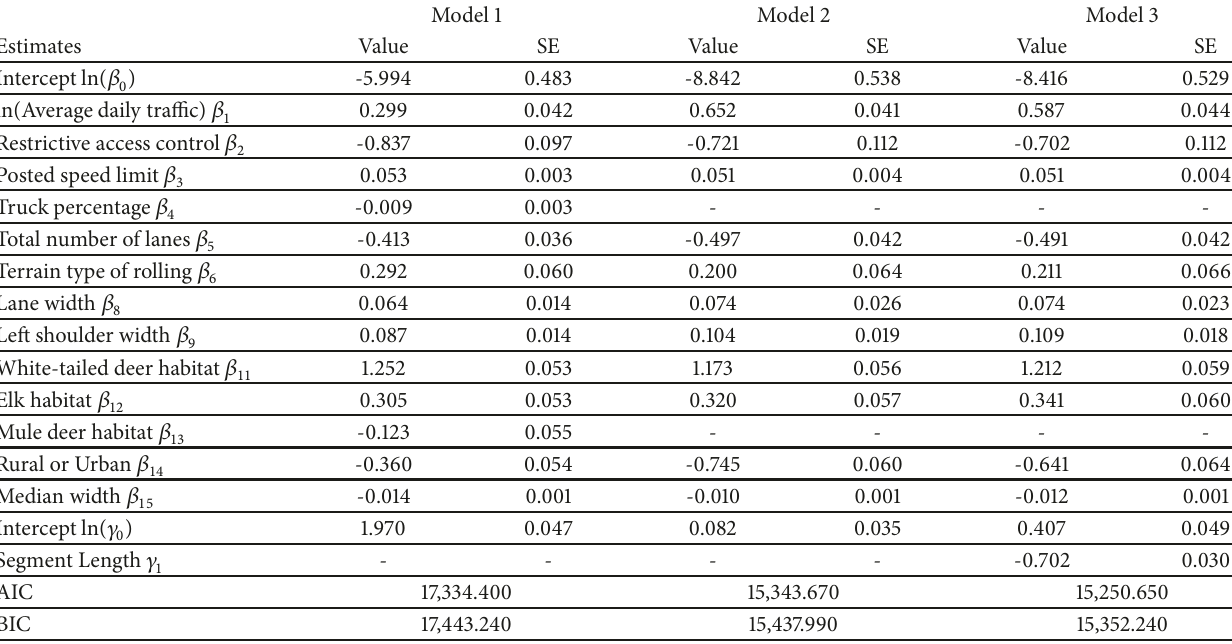
Table 10: Modelling results for the GNB model using the carcass removal data.